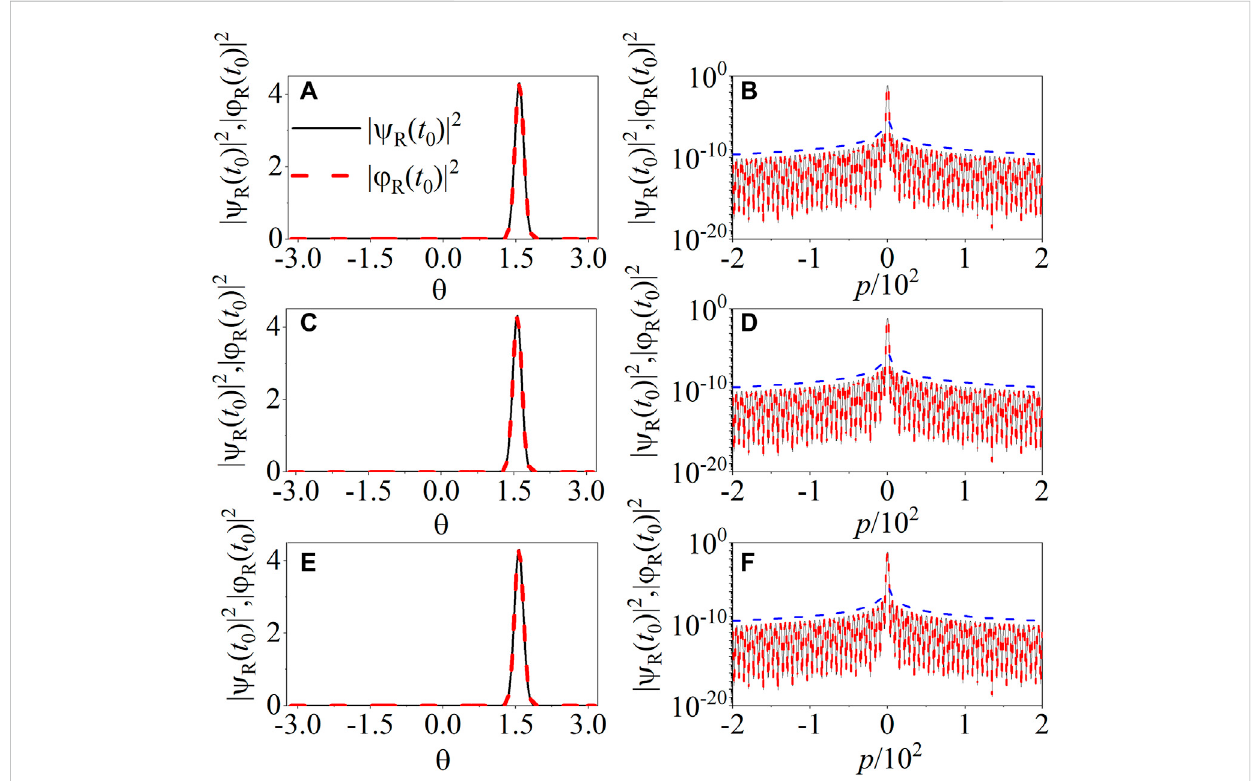
FIGURE 7 Comparison ofthedistributionofstates | ψ R ( t 0 ) 〉 (solid lines) and | φ R ( t 0 ) 〉 (dashed lines) inreal (A,C,E) and momentumspace (B, D,F) with B = p (top panels), p 2 (middlepanels),and p 3 (bottompanels).Bluedashedlinesin (B,D,F) indicatethepower-lawdecay| ψ R ( t 0 )| 2 (| φ R ( t 0 )| 2 ) ∝ p − 2 .Theparametersare the same as in Figure 2.